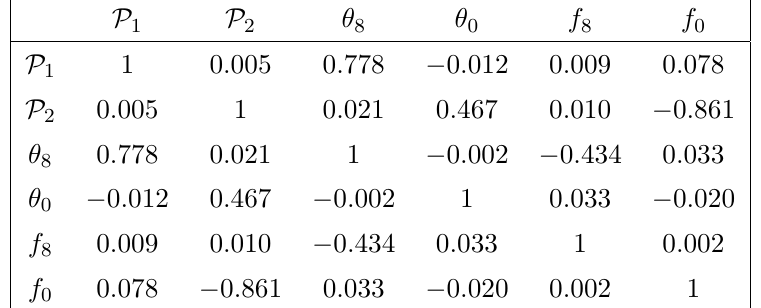
excluding the (cid:25) 0 form-factor m